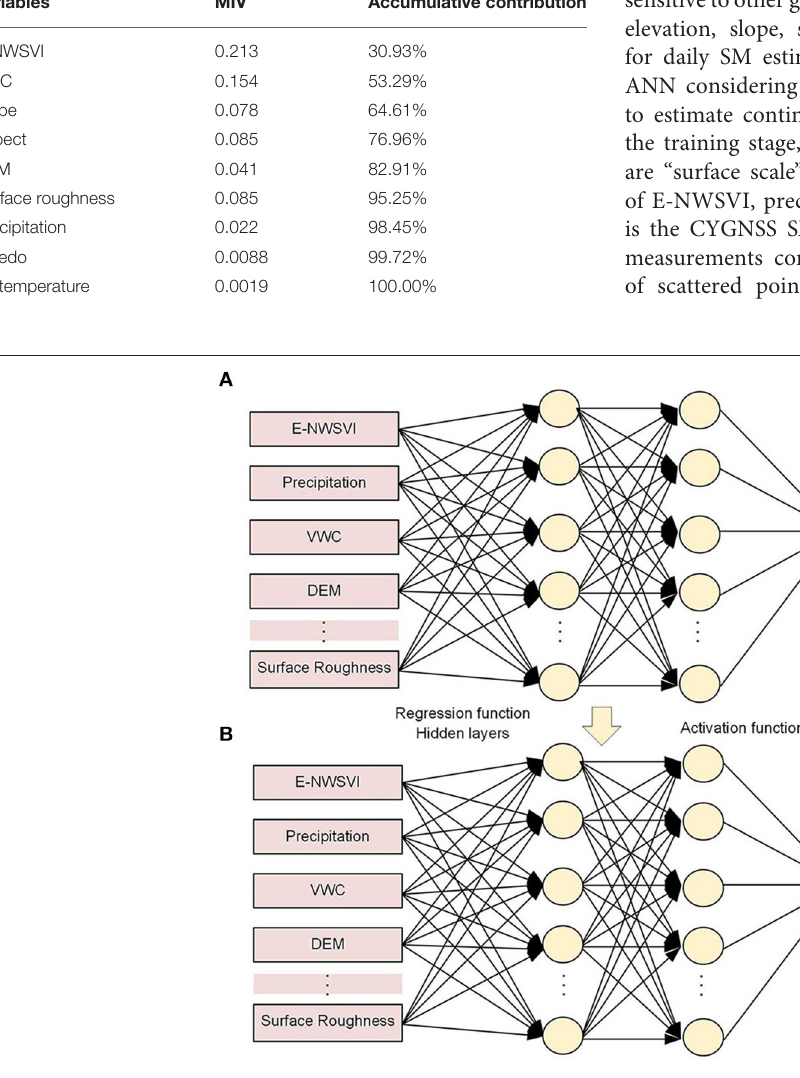
Frontiers in Big Data |